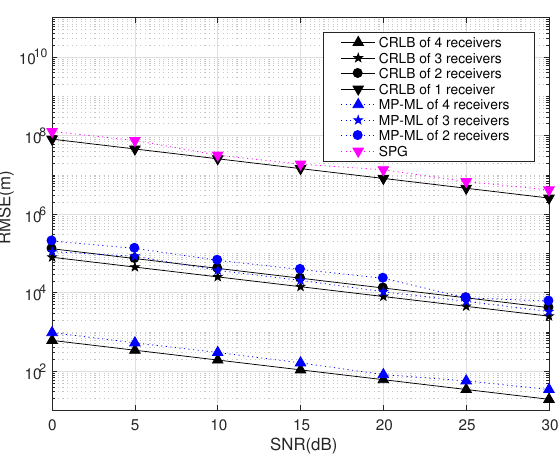
Figure 15. MP-ML and CRLB of different numbers of receivers ( K =